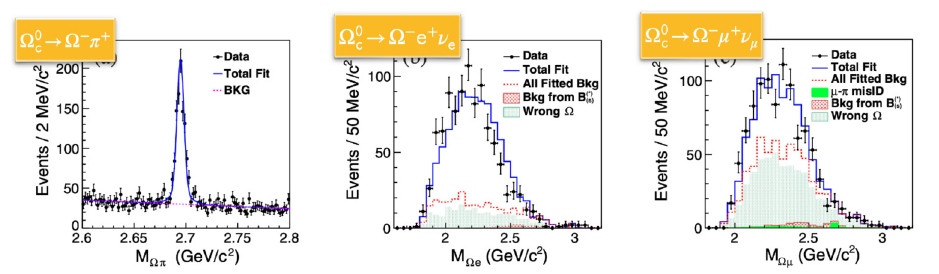
Figure 10. Fit to the M Ω π (left), M Ω e (middle), M Ω µ (right) distributions. The dots with error bars represent the data, the solid lines are the best fits, and the dashed lines are the fitted total background. The blank areas between the red dashed lines and shaded histograms are from backgrounds with mis- selected ` + . The µ − π misID in M Ω µ plot is the background from Ω 0